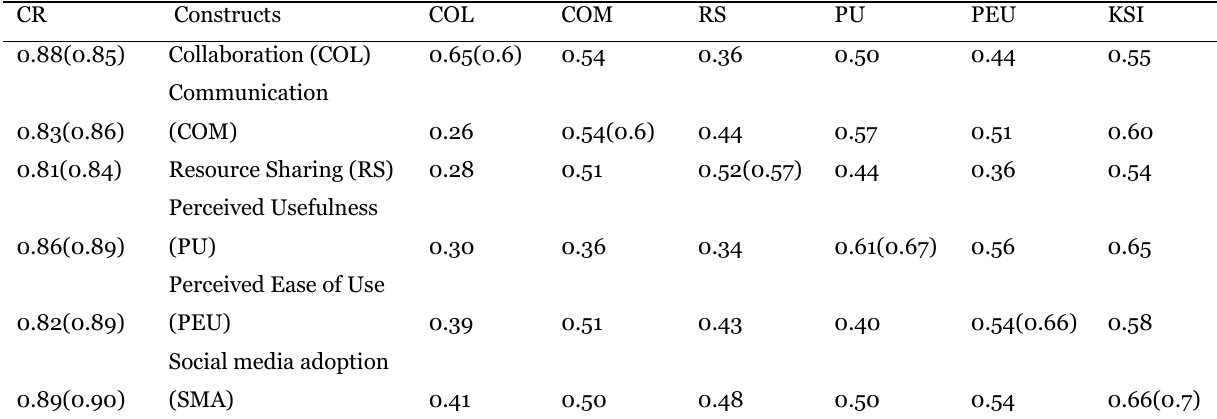
Convergent and Discriminant